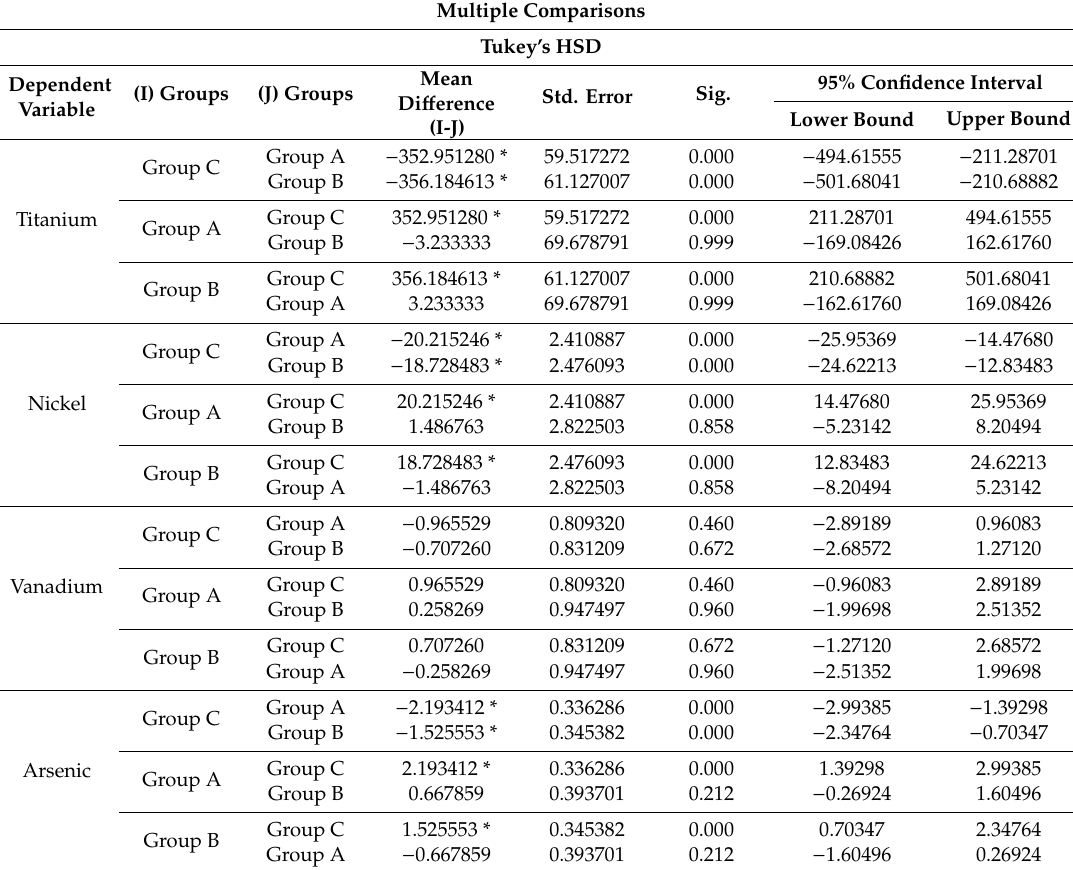
Table 2. Di ff erence in the mean concentration of titanium, nickel vanadium and arsenic in the three